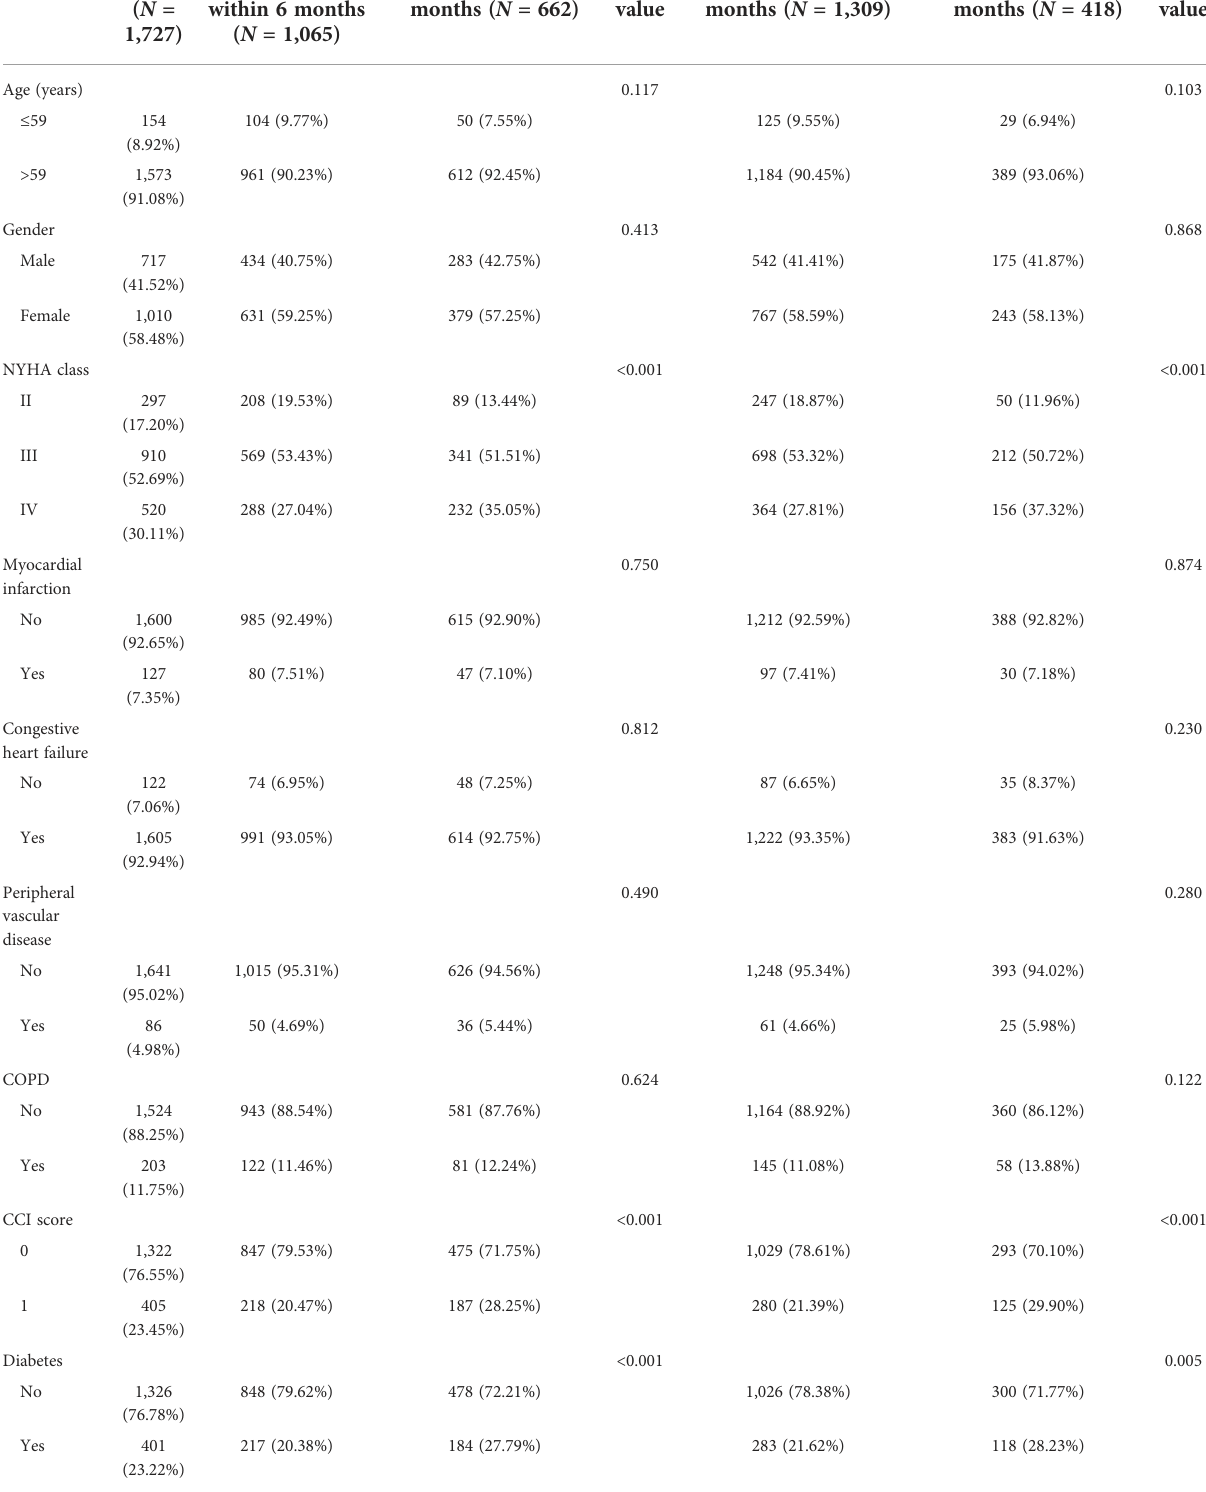
TABLE 1 Univariate analysis of categorical